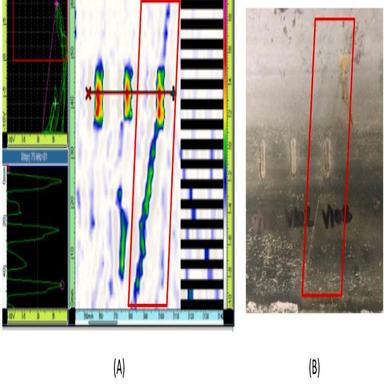
(A) Eca result signals for sample with prefabricated 10 MM vertical notches, (B) real photo of the sample in the scanning region.